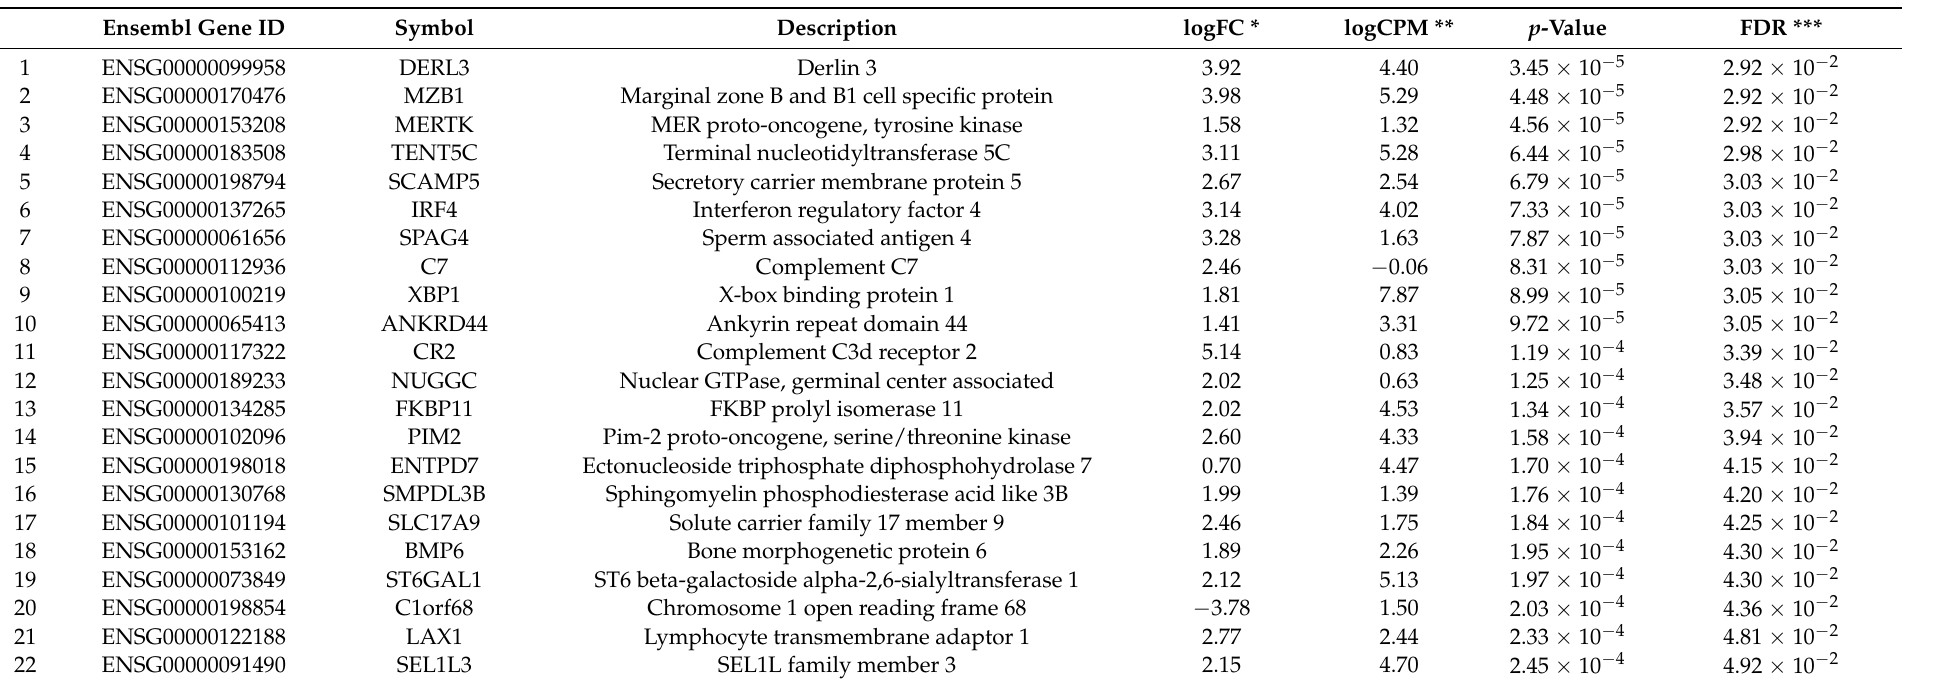
Table 2. Top 22 DEGs identified in periodontal disease gingival